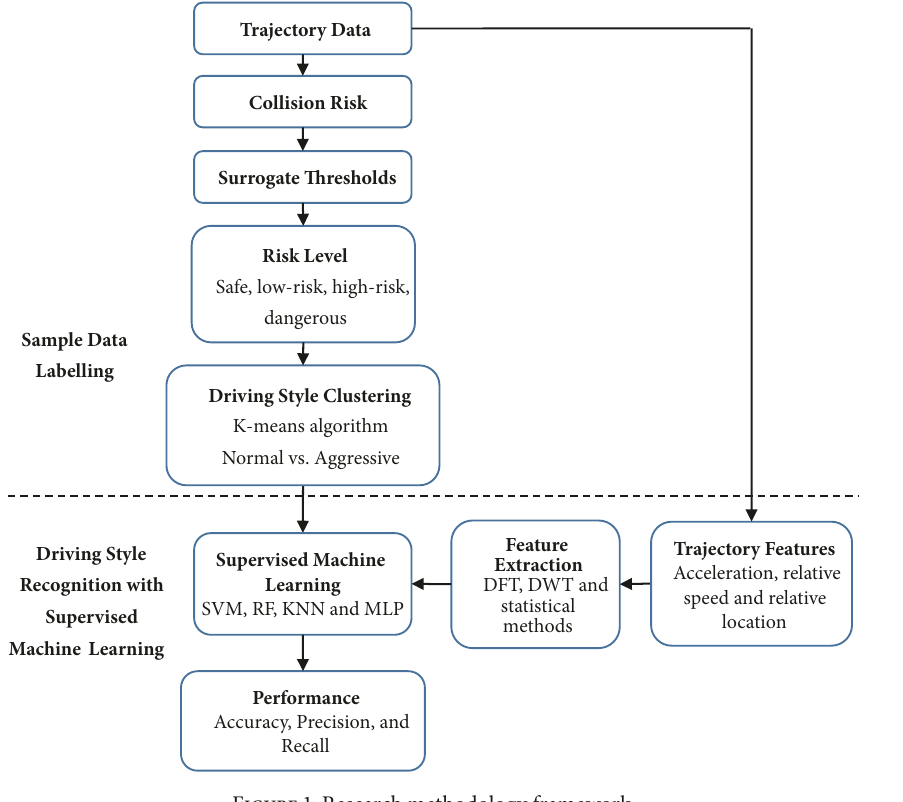
Figure 1: Research methodology